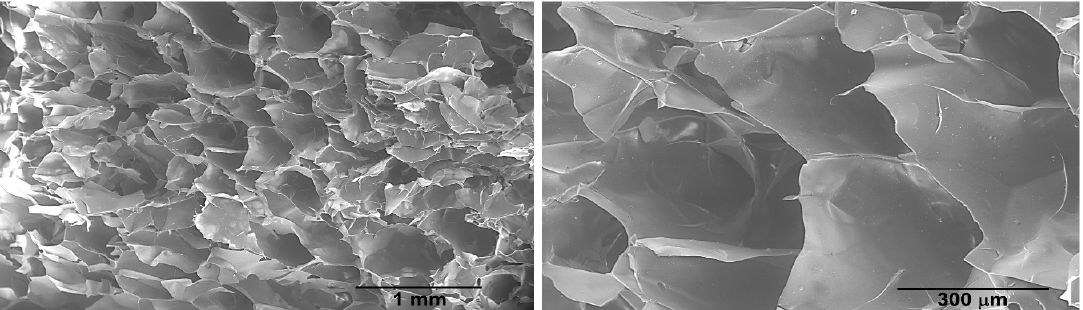
Figure 6. SEM images of cross sections of lyophilized xyl- TCPP-3.